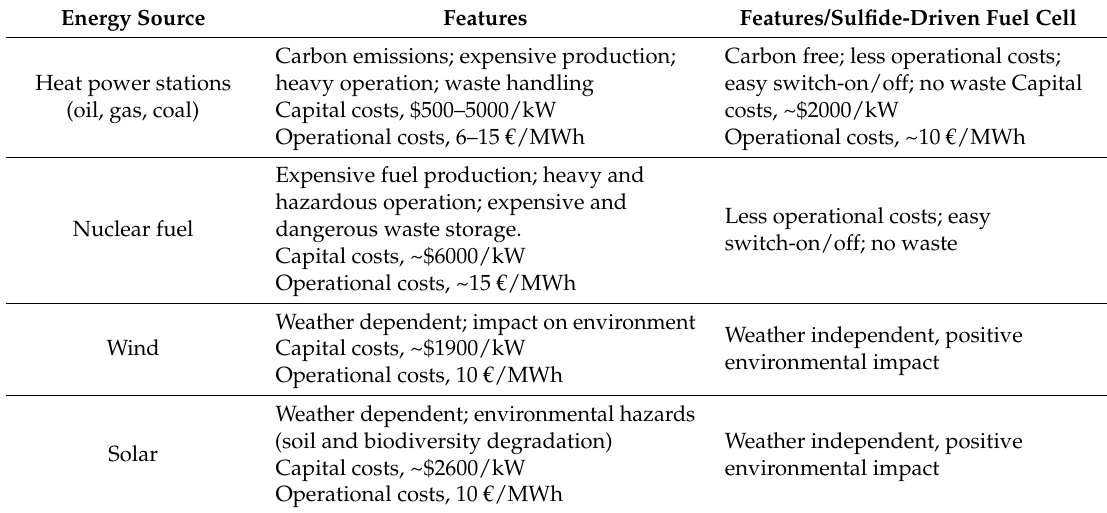
Table 2. Comparison of sulfide-driven fuel cells and other fuels. Data for capital costs for the known fuels are extracted and extrapolated from References [19] and data for operational costs, from References